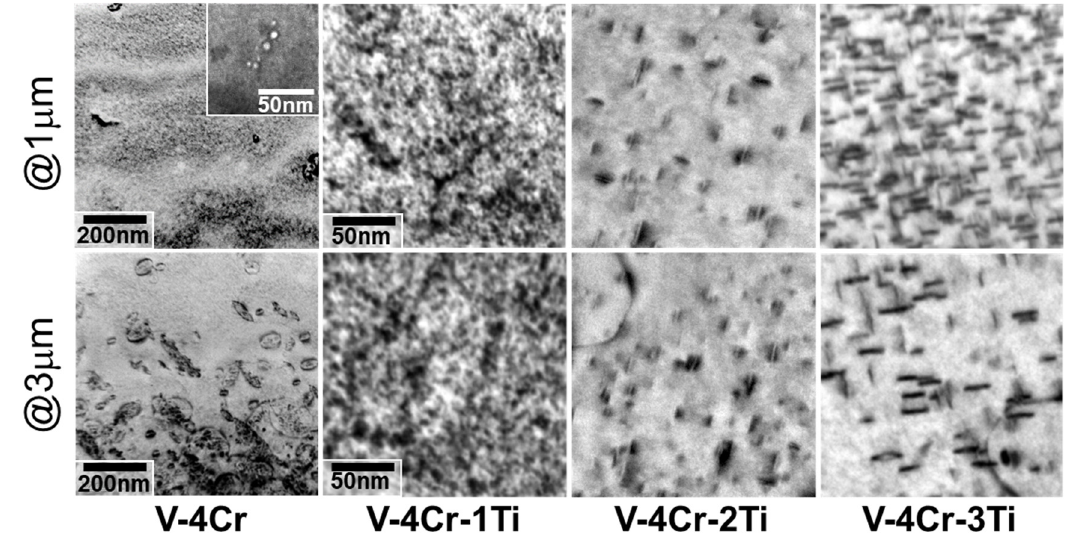
Figure 4. Bright-field TEM images of He-irradiated V–Cr–Ti alloys at 500 °C. Upper parts show high-magnification images at 1-m depth and lower parts show images at a 3 µ m depth. An inserted image of the V–4Cr at a 1 µ m depth shows a void image. Note that the left photo (V-4Cr) has a different magnification than the other ones.